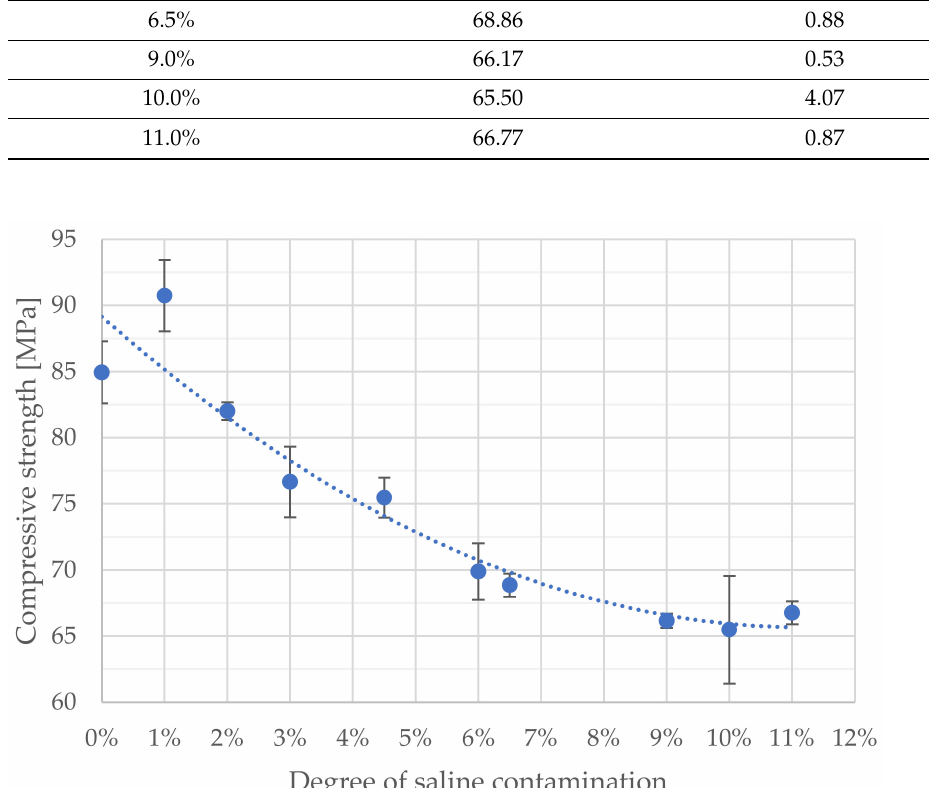
Figure 3. Impact of the degree of cement contamination on the average compressive strength. Table 4. Groups with statistically homogeneous compressive strength levels depending on the degree of cement contamination.